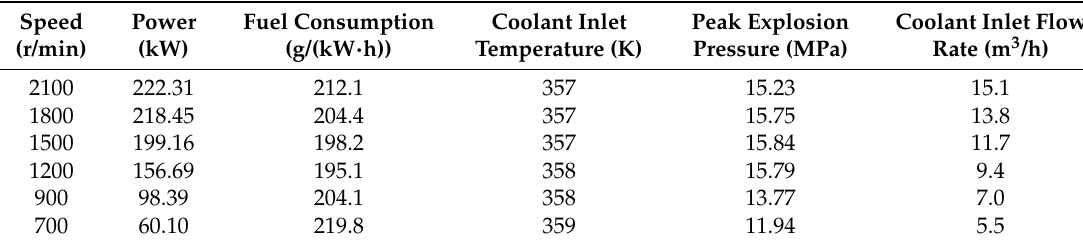
Figure 3. Mesh of the single cylinder engine model.